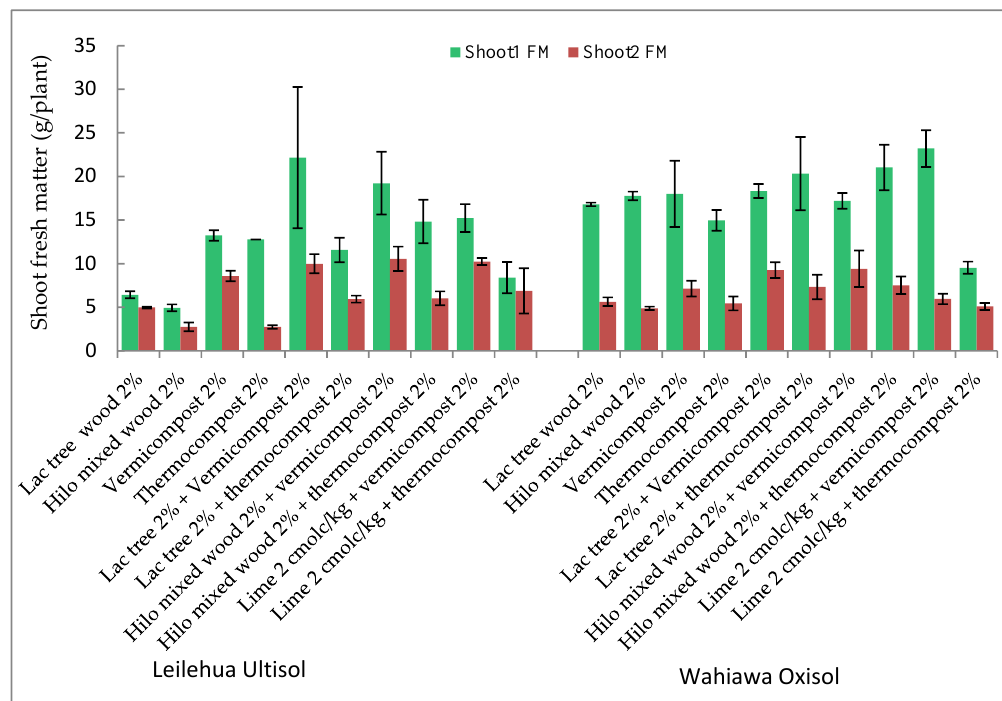
Figure 2. Chinese cabbage shoot fresh weight as affected by biochar, lime, and/or compost additions. FM = fresh matter, 1 and 2: first and second plantings; Error bars: standard error of the mean ( n = 3).